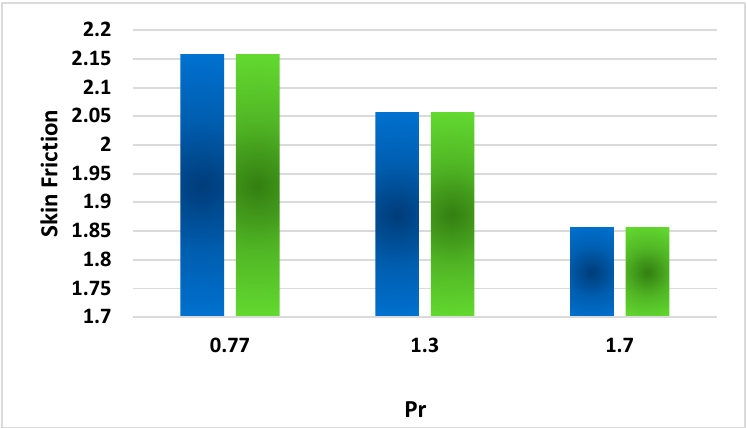
Figure 16. Revealing the consequences of Pr with the related skin friction coefficient.